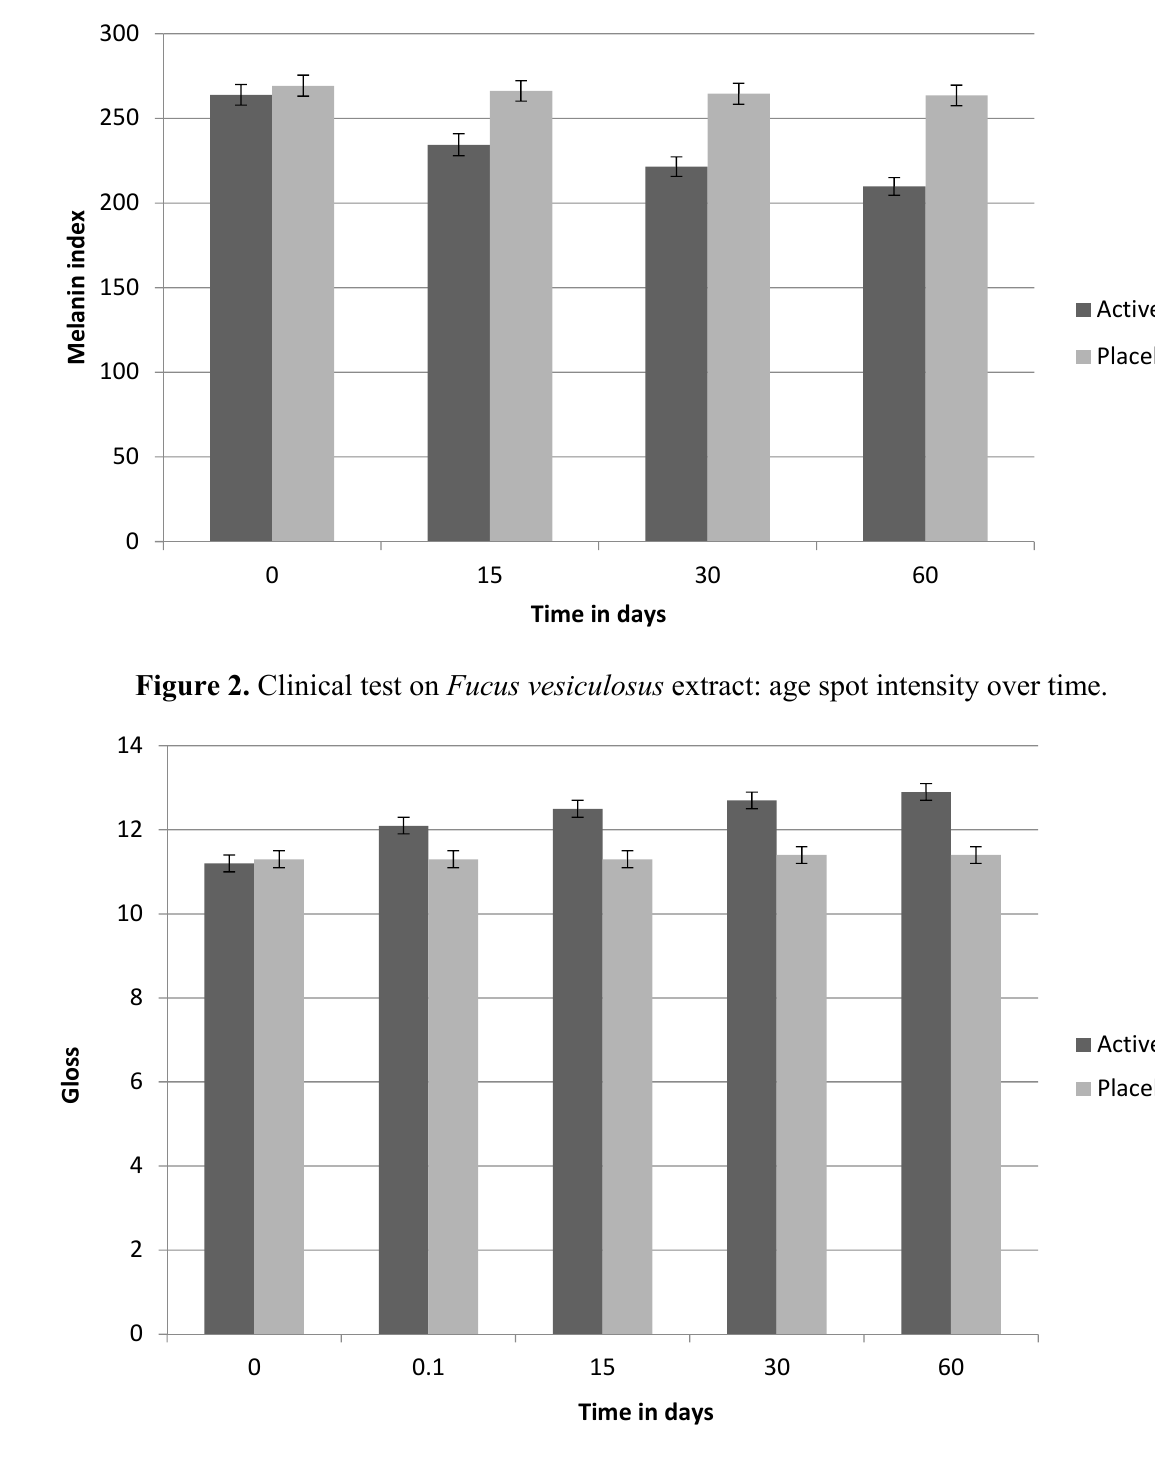
Figure 3. Clinical test on Fucus vesiculosus extract: brightness (gloss) factor, over